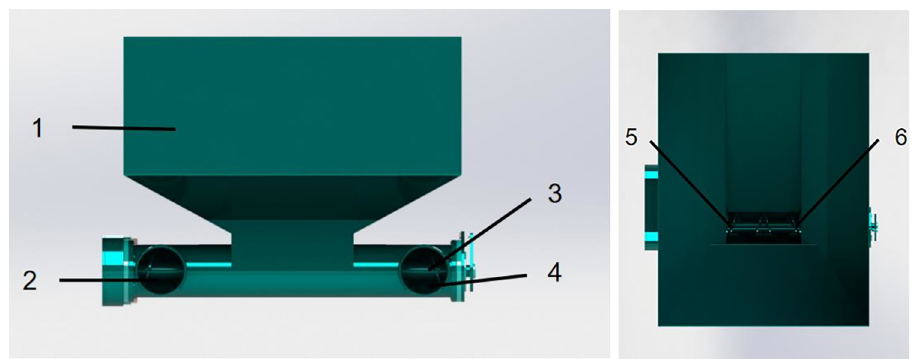
Fig 2. Spiral fertilizer discharger structure. (a) Front view; (b) Top view. 1. Fertilizer tank 2. left discharge port 3. spiral shaft 4. right discharge port 5. Left row fertilizer spiral 6. Right row fertilizer